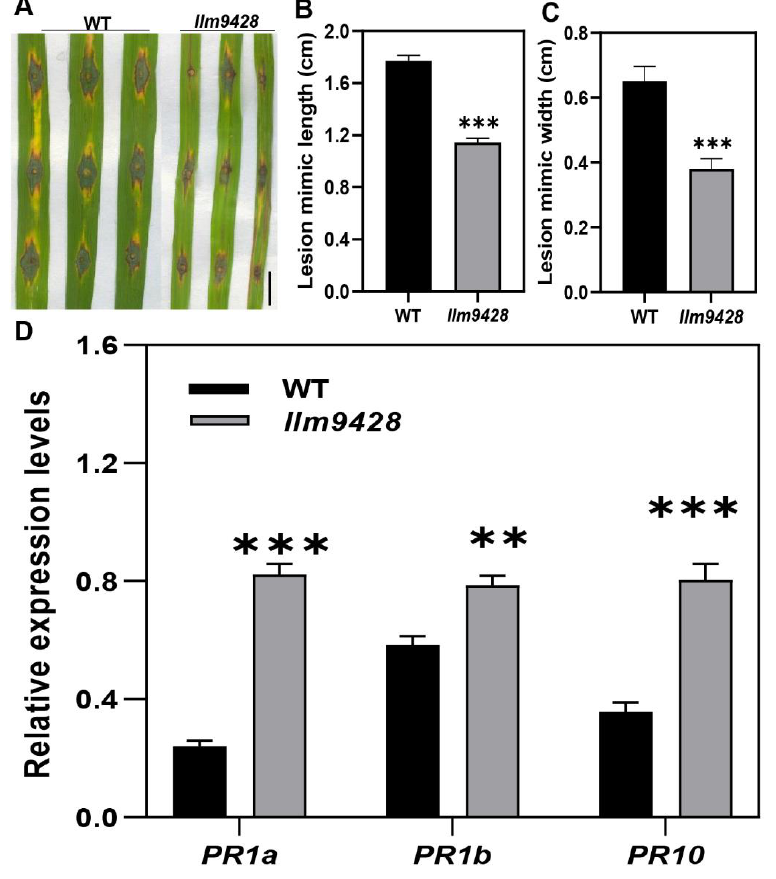
Figure 3. llm9428 has enhanced blast disease resistance compared to WT. ( A ) The phenotype of disease lesions of WT and llm9428 at four-leaf stage, ( B ) length and ( C ) width of disease lesions in WT and llm9428 . ( D ) The relative expression levels of PR-genes in WT and llm9428 . The data presented in B-C is the average of 10 leaves. Mean and SD were obtained from three independent measurements. Statistical analysis was performed using Student’s t -test, ** and *** indicate p < 0.01 and p < 0.0001, respectively. Scale bar: 1 cm in A .